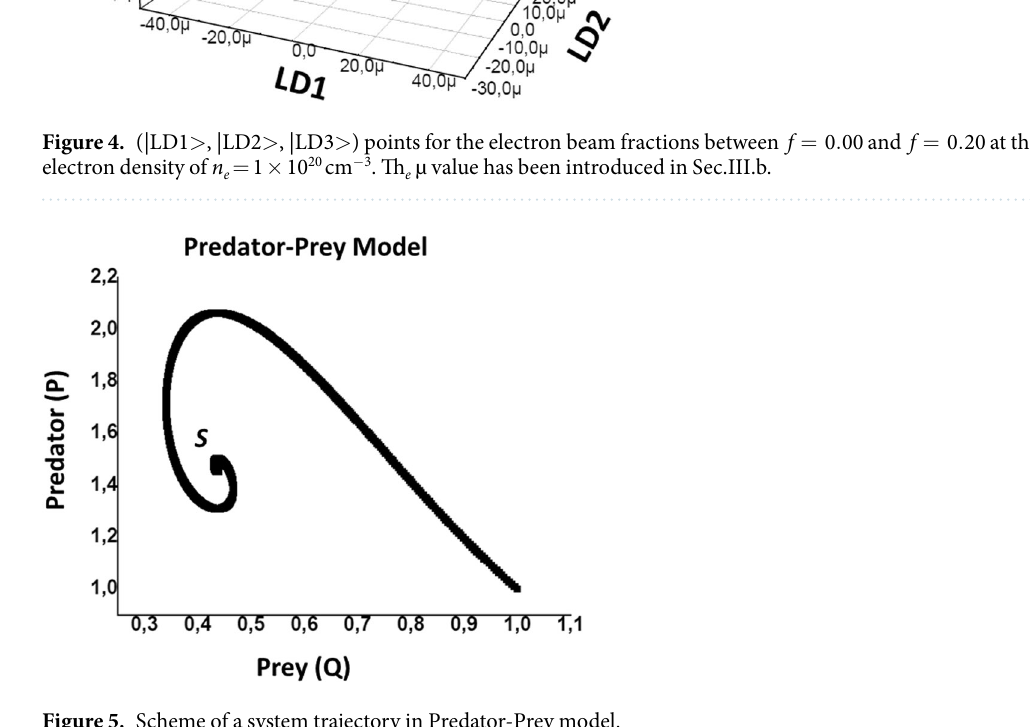
Figure 5. Scheme of a system trajectory in Predator-Prey